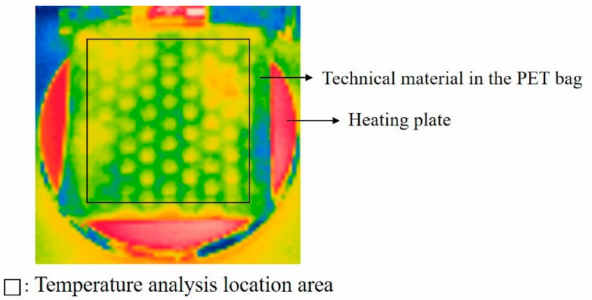
Figure 5. Temperature analysis location in thermogram image (top